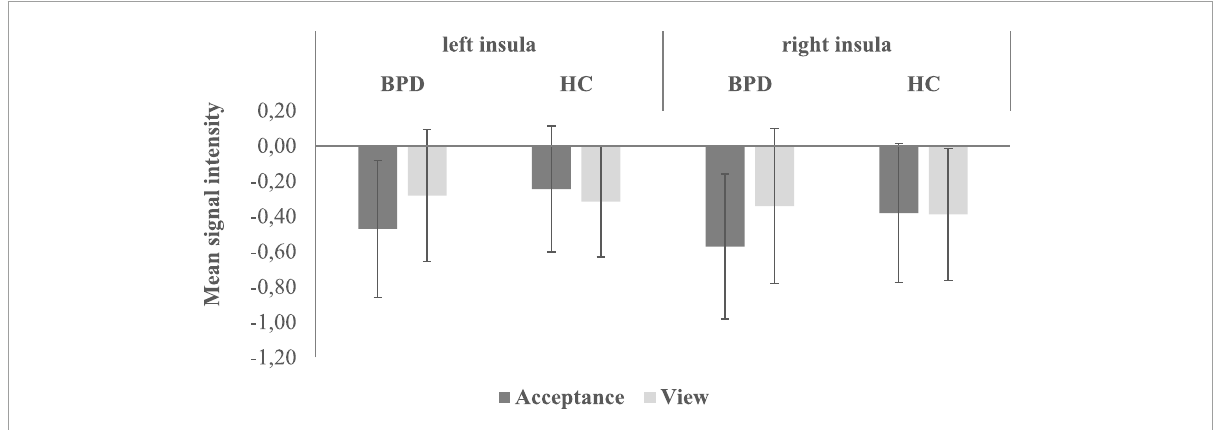
FIGURE2 Mean signal intensity (beta-weights) in the left and right insula during emotional acceptance and passive viewing in BPD patients and HC. There was a significant emotion regulation condition × group interaction ( F 1 , 42 = 9.58, p = 0.003, η 2 = 0.186), indicating a stronger acceptance-related deactivation in the BPD group compared to the HC. BPD, borderline personality disorder; HC, healthy